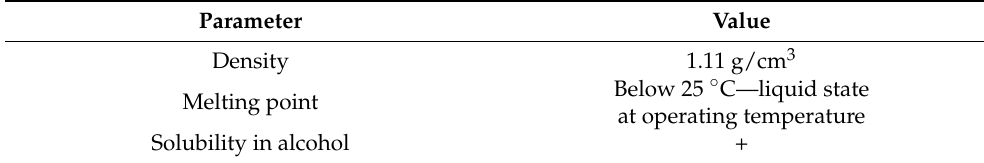
Table 1. Aqua Clear Resin properties